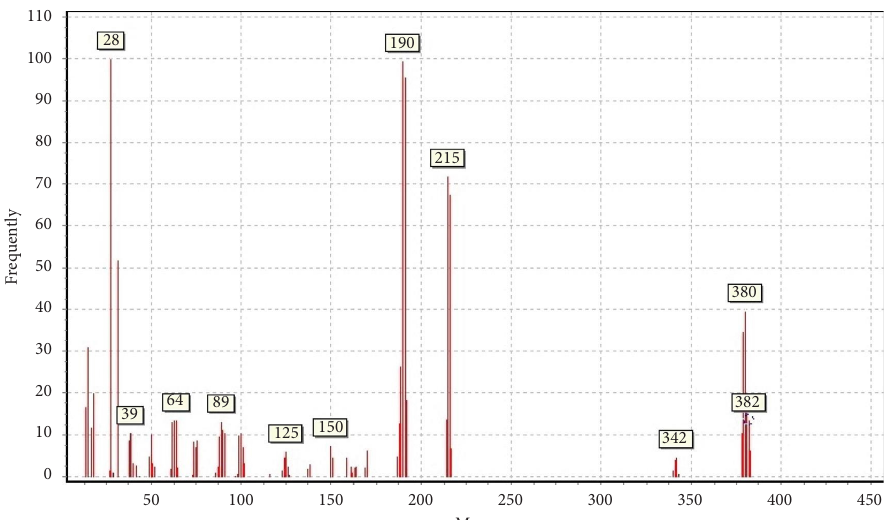
Figure 1: EI-MS electronic spectra images of compound